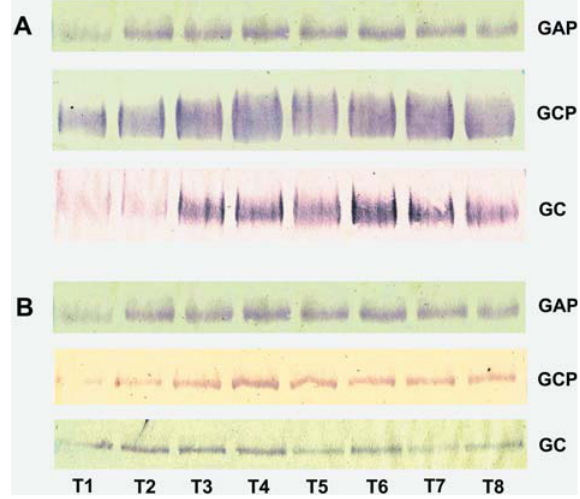
- Representative Western blots of MG2 pattern observed in all individuals from each group. B - Representative Western blots of lactoferrin pattern observed in all individuals from each group. T1–T4 (non-stimulated submandibular and sublingual saliva-SMSL) and T5–T8 (stimulated submandibular and sublingual saliva-SMSL).